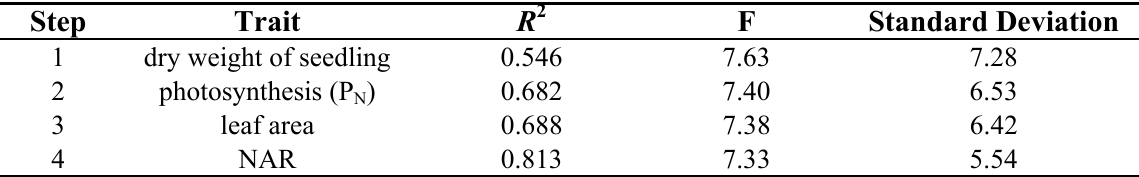
Table 5. Results of stepwise multiple regression for SI indexes of the final yield of grains and seedlings parameters after drought stress ( N = 20).